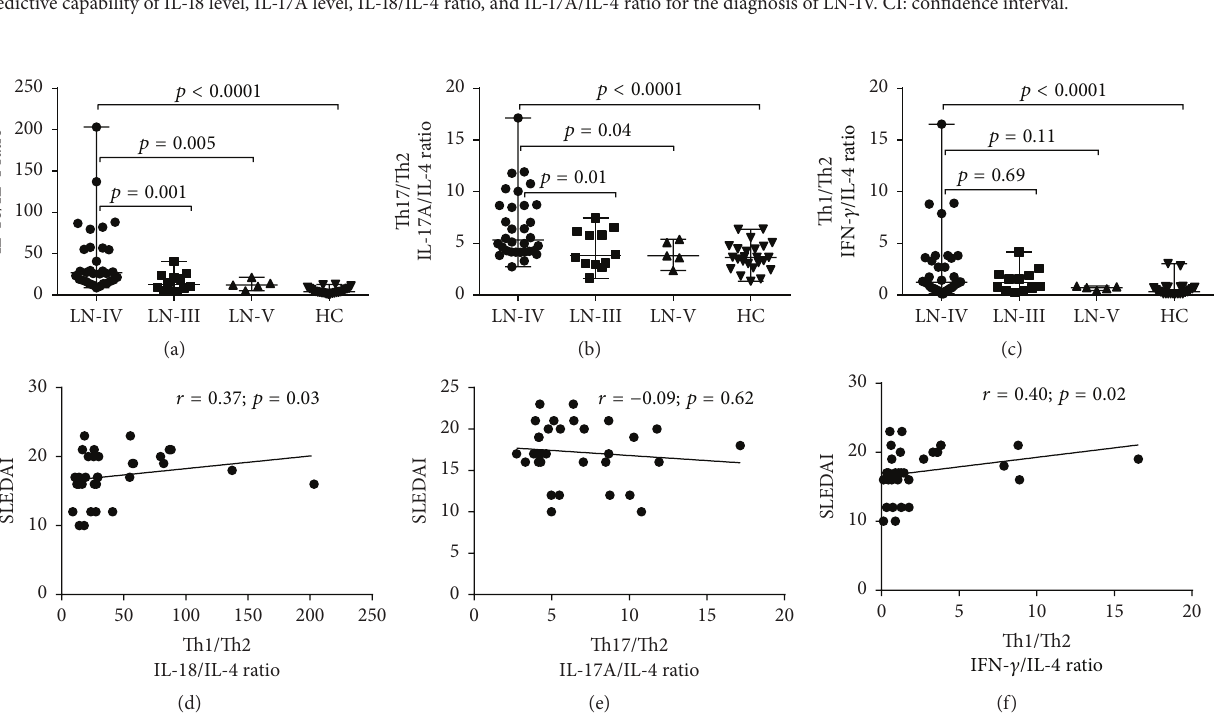
Figure 3: Comparison of the ratio of Th1, Th2, and Th17 cells expressed cytokines in patients with different classes of LN and healthy controls and their correlationship with SLEDAI. (a) Th1/Th2 cells cytokines IL-18/IL-4 ratio was significantly increased in LN-IV compared to other classes of LN-III ( 𝑝 = 0.001 ), LN-V ( 𝑝 = 0.005 ), and healthy control ( 𝑝 < 0.0001 ). (b) The Th17/Th2 cell cytokines IL-17A/IL-4 ratio was significantly higher in LN-IV when compared with LN-III ( 𝑝 = 0.04 ), LN-V ( 𝑝 = 0.01 ), and healthy control ( 𝑝 < 0.0001 ). (c) Similarly, Th1/Th2 cell cytokines IFN- 𝛾 /IL-4 ratio was significantly elevated in LN-IV compared to HC ( 𝑝 < 0.0001 ). IL-18/IL-4 and IFN- 𝛾 /IL-4 ratios were significantly correlated with SLEDAI ( 𝑟 = 0.37 ; 𝑝 = 0.03 and 𝑟 = 0.40 ; 𝑝 = 0.02 ) in LN-IV patients (d, f). IL-17A/IL-4 negatively correlated with SLEDAI ( 𝑟 = −0.09 ; 𝑝 = 0.62 ) but statistically was not significant (e). Mann–Whitney test was applied for group comparison and Spearman correlation test was used to see the correlationship between two parameters. 𝑝 value < 0.05 was considered statistically